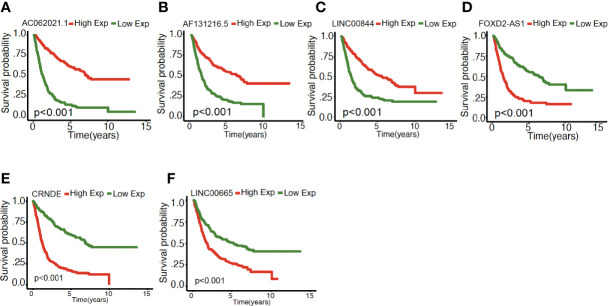

(A–F) Mentioned gene in Kaplan–Meier analysis in the training cohort.